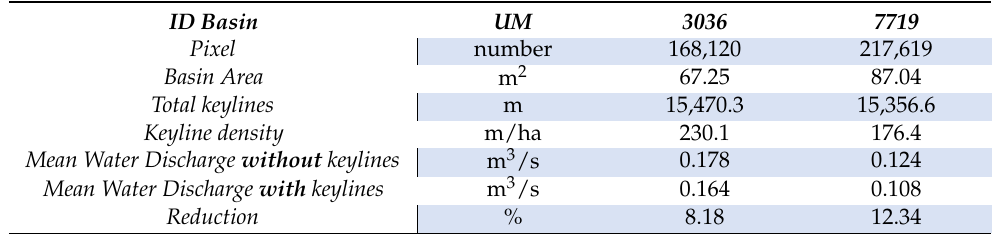
Table 1. Main results obtained from the analysis with the SIMWE model (UM: unit of measurement).